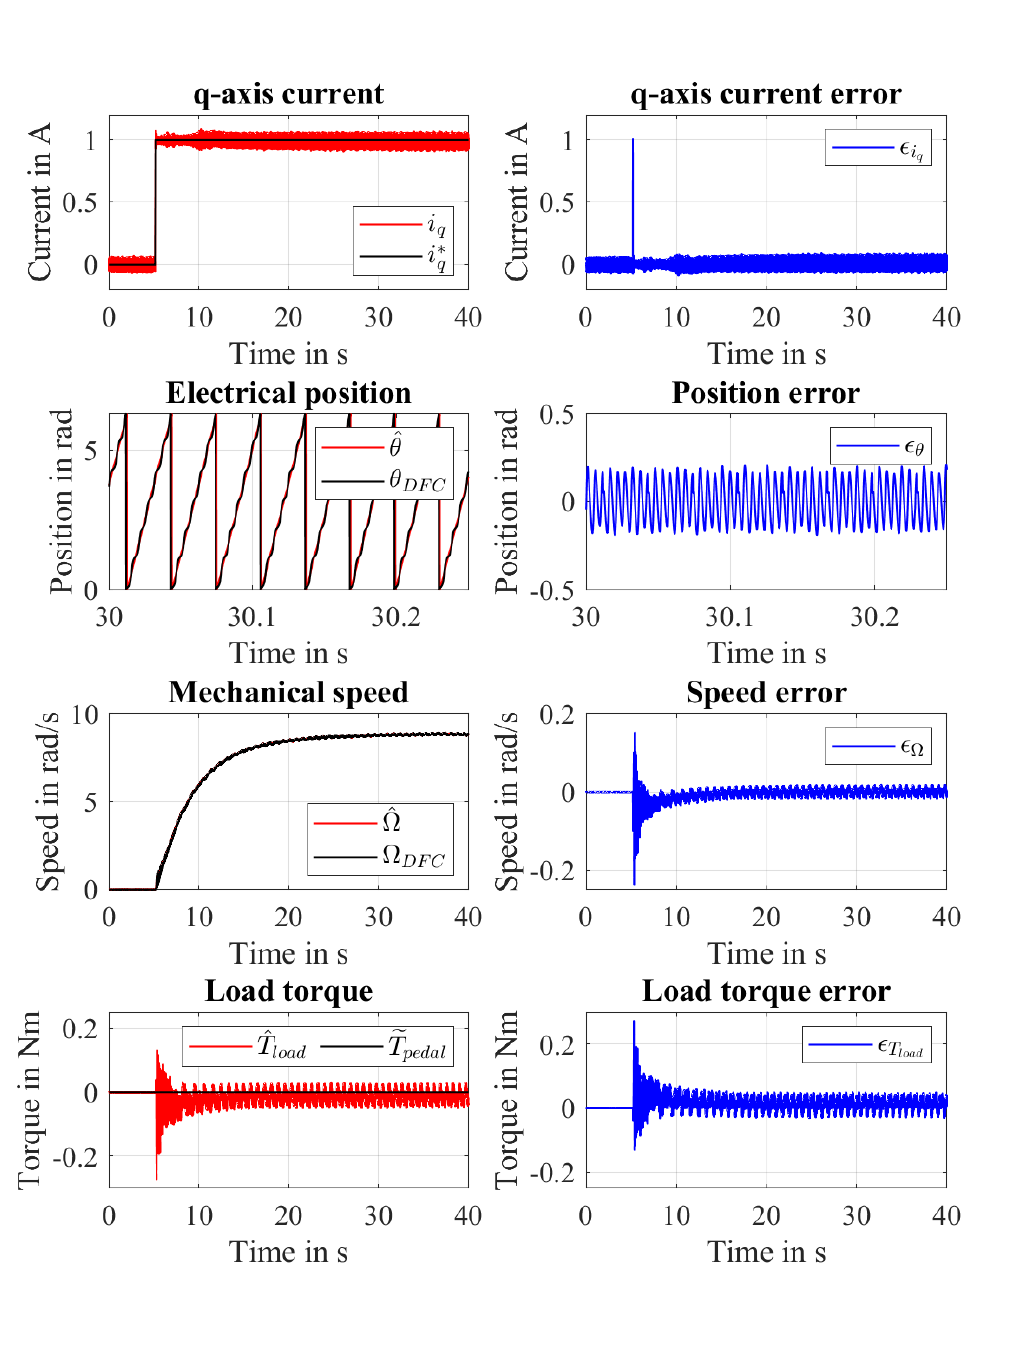
Figure 10. Experiment E1 : Torque control without an applied load